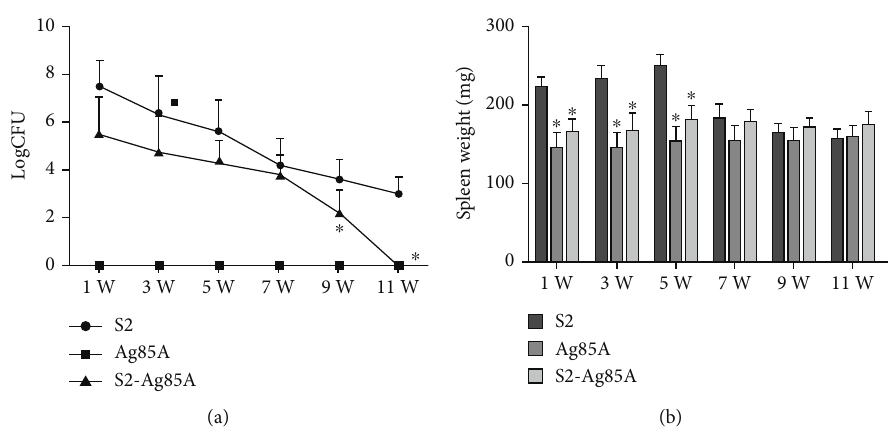
Figure 3: The S2-Ag85A oral vaccine attenuates toxicity in mice. (a) The bacterial content in the spleen was measured at the 1st, 3rd, 5th, 7th, 9th, and 11th week after the completion of vaccination, and the bacterial content showed signi fi cantly lower in the mice-spleen of the S2-Ag85A group than that in the S2 group at the 9th week and 11 weeks ( P value < 0.05). (b) Determination of the spleen weight at the 1st, 3rd, 5th, 7th, 9th, and 11th weeks after the vaccination; the spleen of mice in the S2 group was swollen at the 1st, 3rd, and 5th week, and the weight elevated with a signi fi cant level ( P < 0 : 05 ), and then gradually, it returned to normal; the similar weight of mice spleen was found in the S2-Ag85A and Ag85A groups. ∗ P value < 0.05, compared with the S2 group.